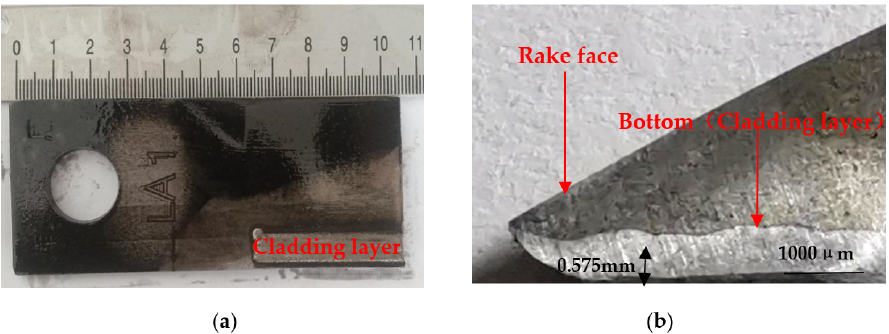
Table 1. 65 Mn chemical composition of the matrix material.